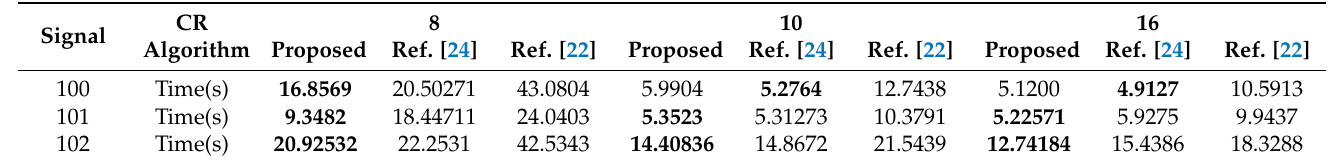
Table 4. Processing time of the proposed and existing techniques in seconds for ECG compression.